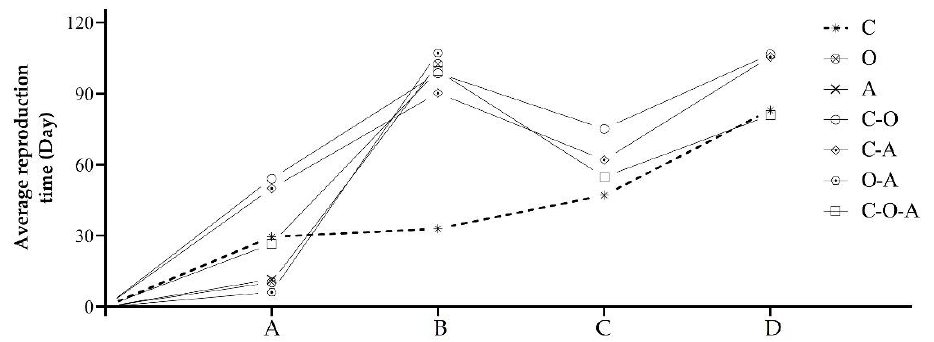
Figure 2. Reproductive time in the behavior of each pollen treatment (the deaths of queens were considered): (A) initial nesting; (B) initial egg laying; (C) first worker emergence; (D) colony reaching ten workers.